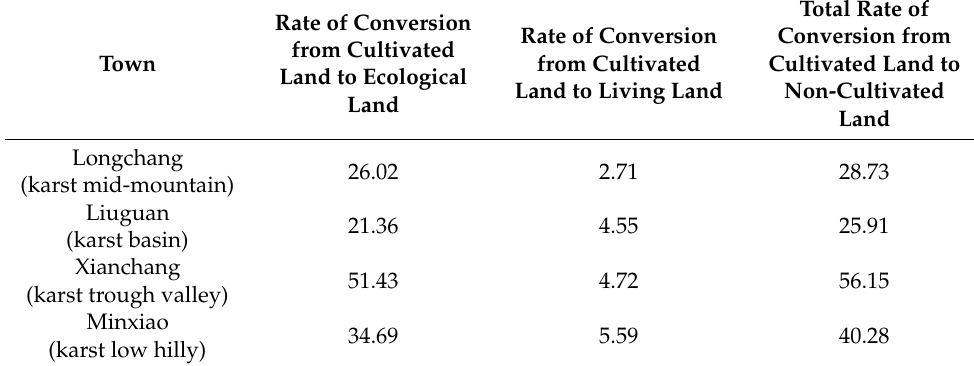
Total Rate of Conversion from Cultivated Land to Non-Cultivated Land